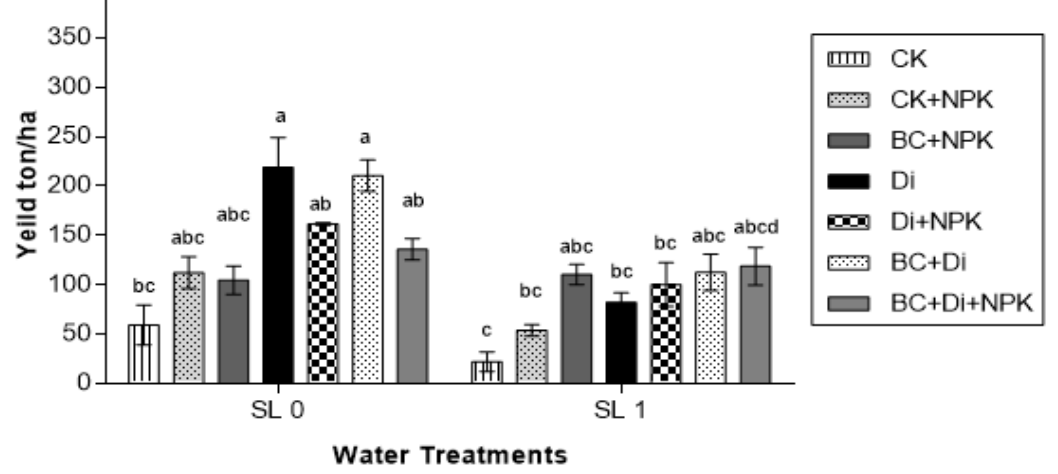
Figure 5. Effect of biochar and digestate treatments on yield of Chinese melon under different saline water treatments (SL0 and SL1).